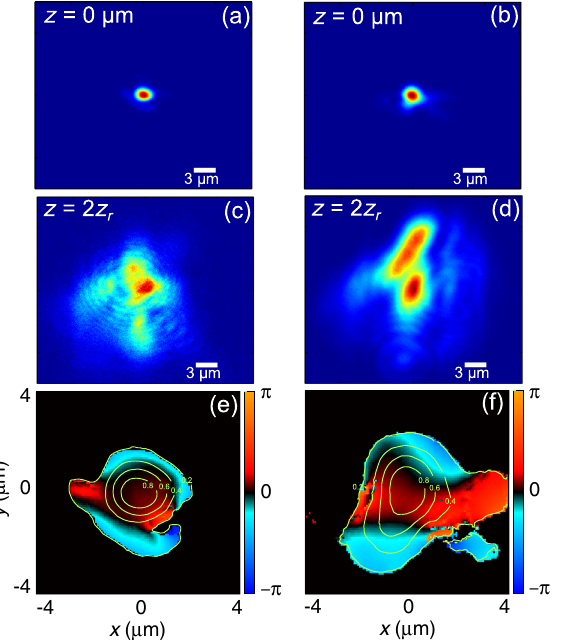
FIG. 3. Laser focal spots and wave fronts. (a),(b) Laser focal spots for two different runs. (c),(d) Corresponding midfield laser transverse distribution at z ¼ 2 z R . (e),(f) Corresponding recon- structed laser phase at the focal plane.